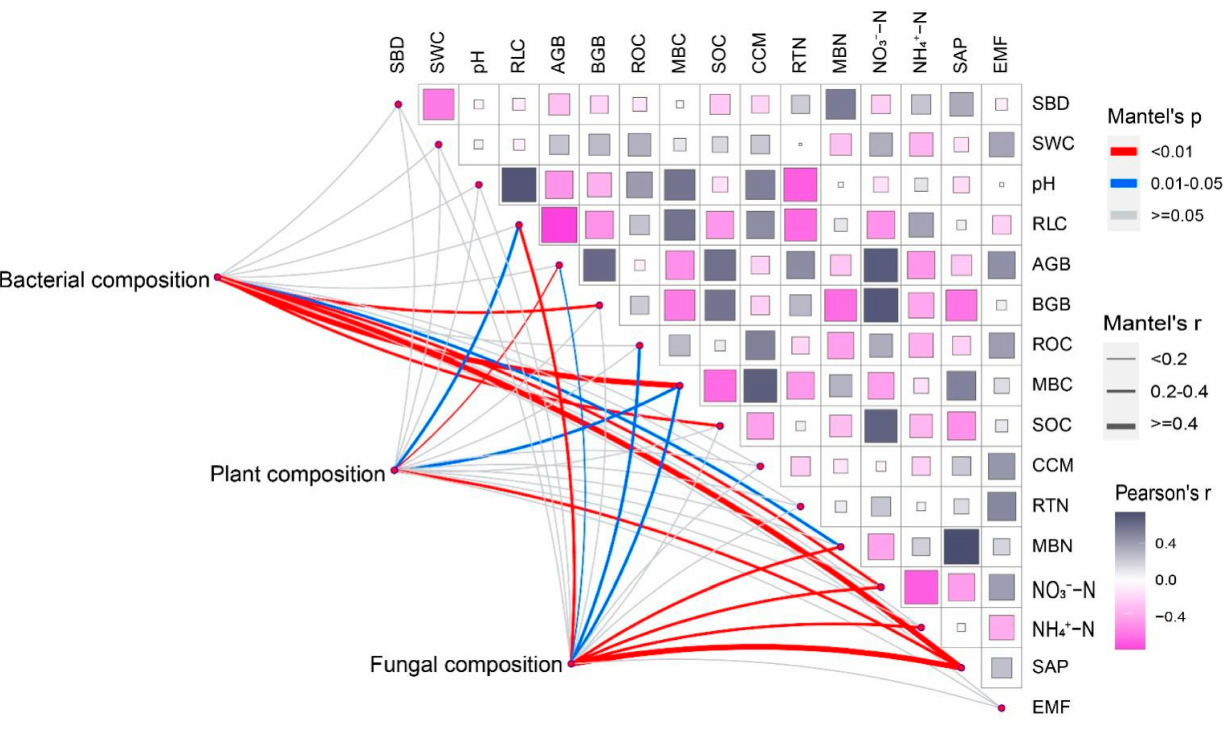
Figure 5. Mantel test analysis of ecosystem parameters and abiotic factors and plant and microbial composition on operational taxonomic units (OTUs). Abbreviations: pH, soil acidity and alkalinity; SBD, soil bulk density; SWC, soil water content; RLC, relative light conditions; AGB, aboveground biomass; BGB, belowground biomass; ROC, roots organic carbon; MBC, microbial biomass carbon; SOC, soil organic carbon; CCM, cumulative carbon mineralization; RTN, roots total nitrogen; MBN, microbial biomass nitrogen; NO 3 − − N, soil nitrate nitrogen; NH 4+ − N, soil ammonia nitrogen; SAP, soil available phosphorus; EMF, ecosystem